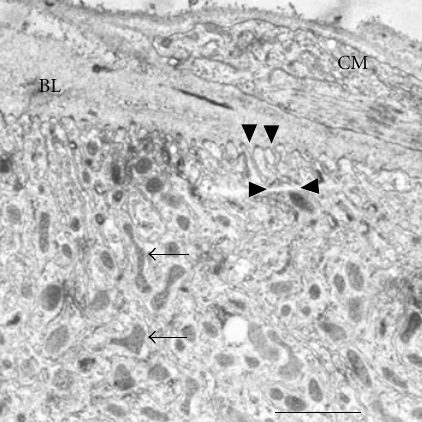
Figure 12: The base of a midgut columnar epithelial abuts against the basal lamina (BL) and circular muscle (CM). Fine, finger-like projections of the basal lamina cause invaginations of the epithelial cell plasma membrane (arrowheads). Mitochondria in the epithelial cell are indicted by the arrows. Scale bar = 1 μ m.